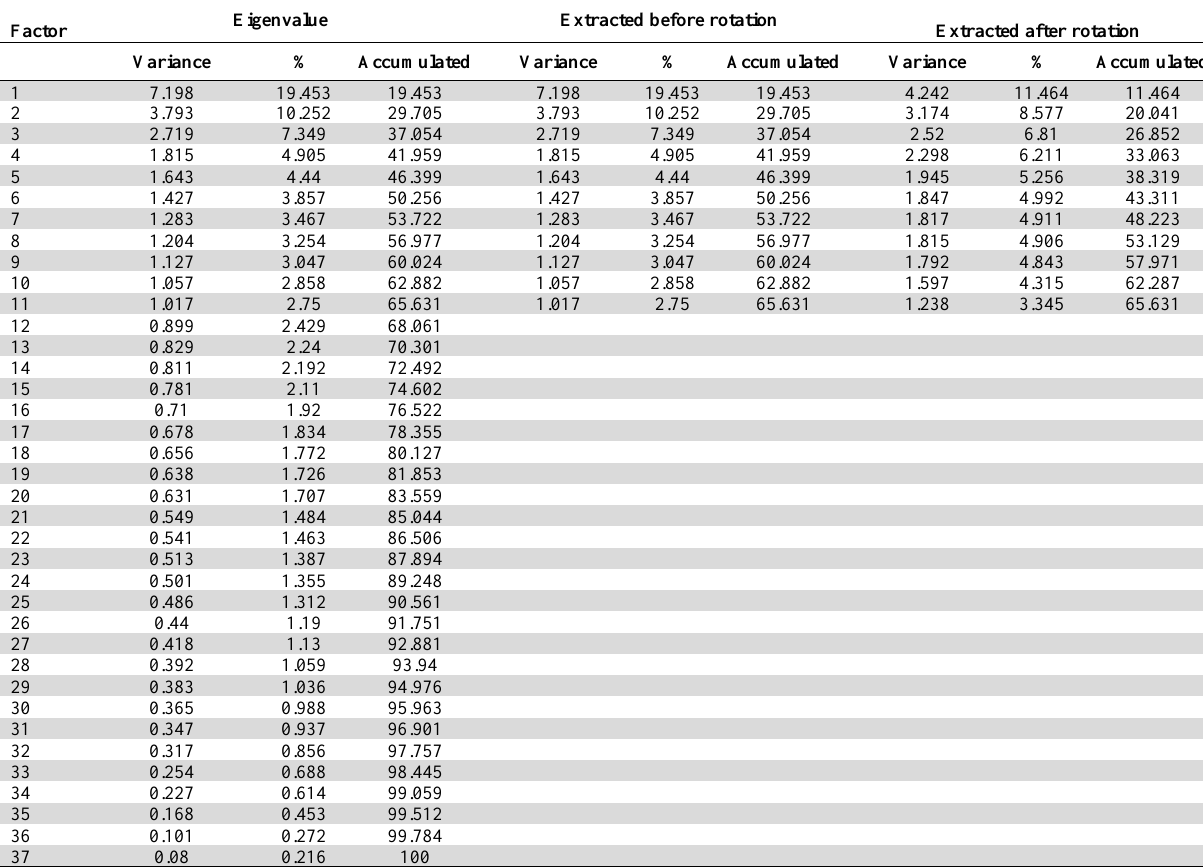
The summary of the results of Factor